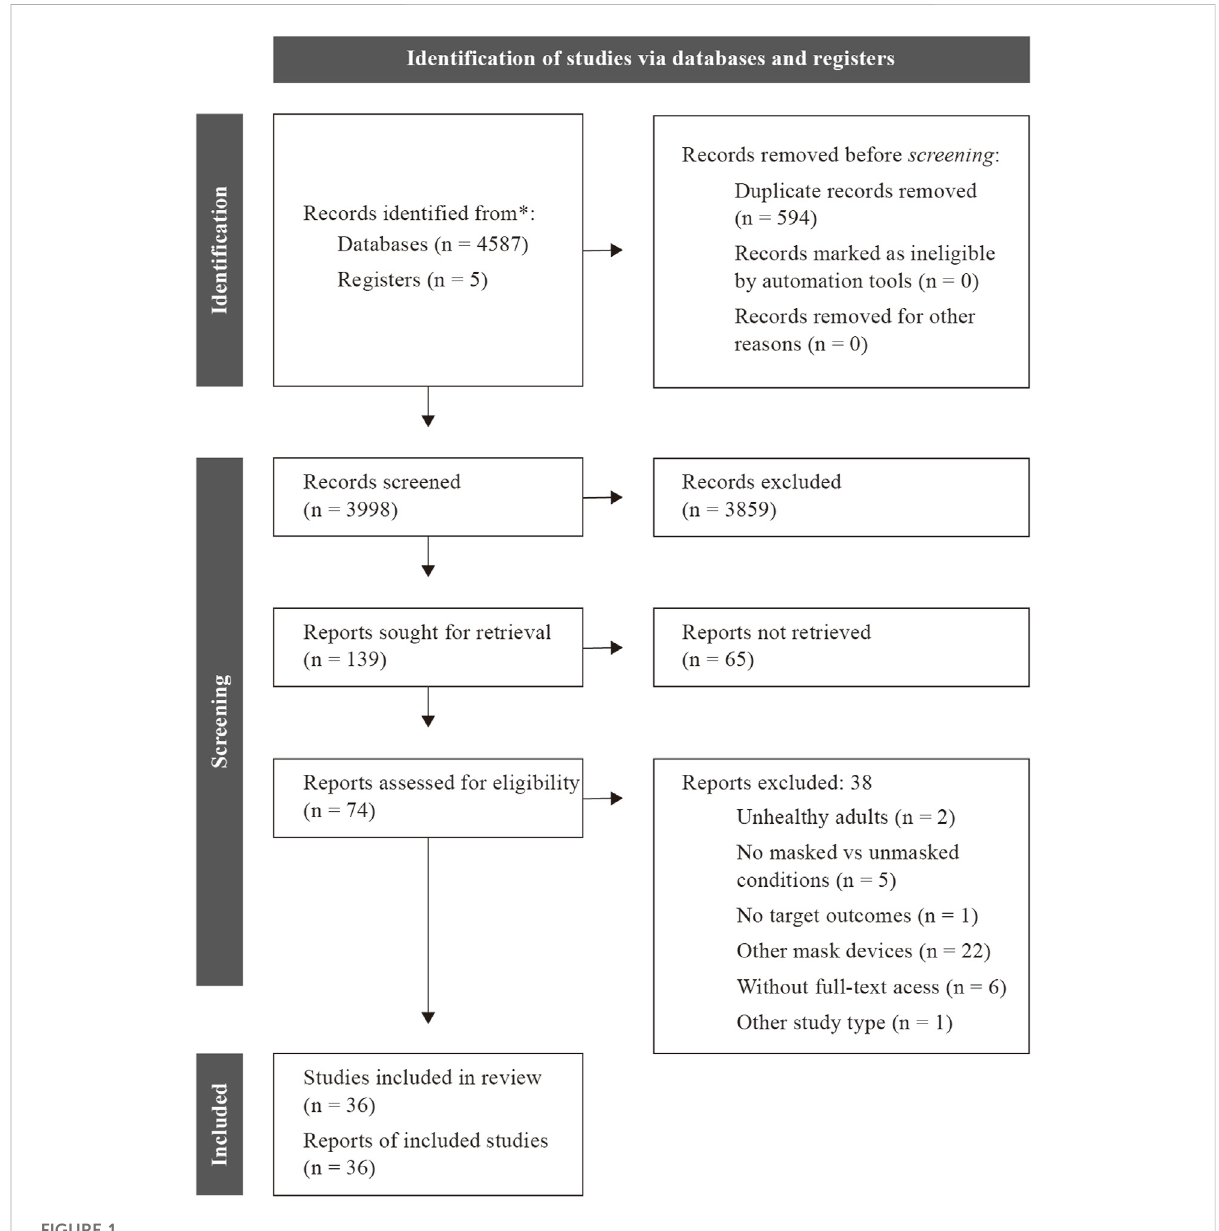
FIGURE 1 PRISMA chart of the study fl